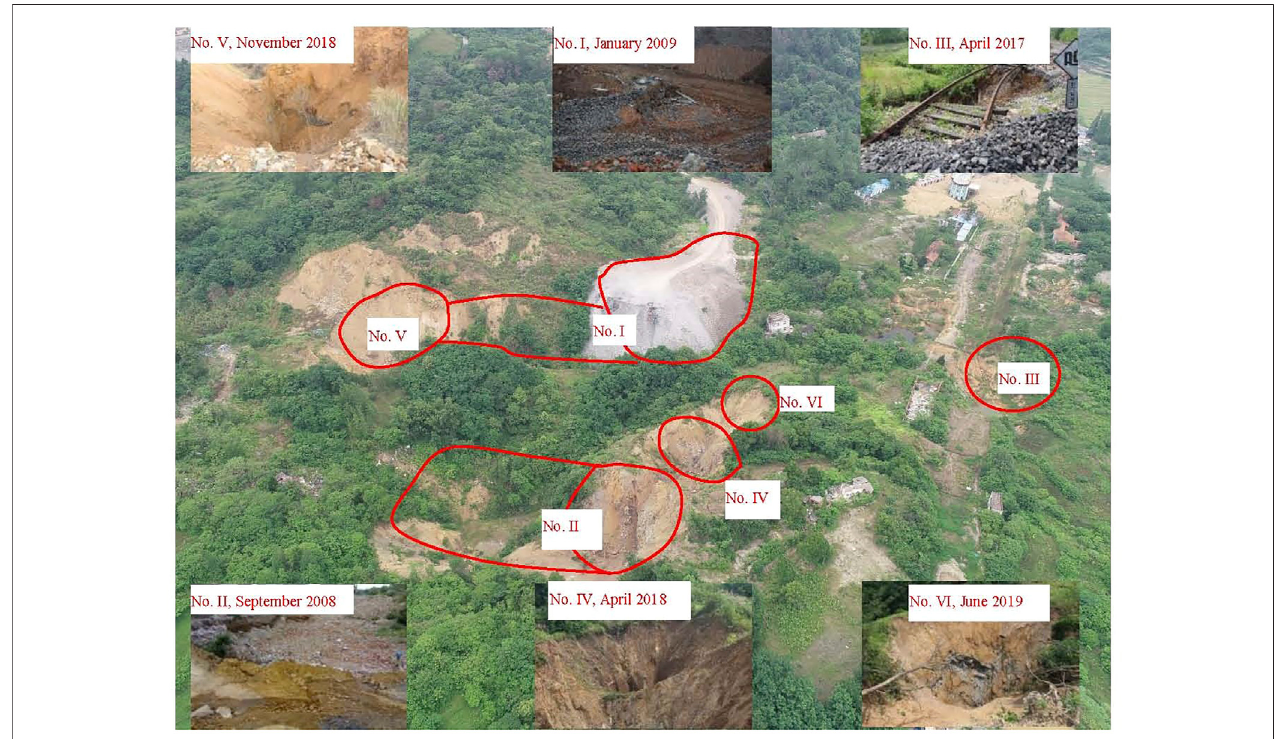
FIGURE 4 | Aerial photographs of the mined-out area (main image captured in May